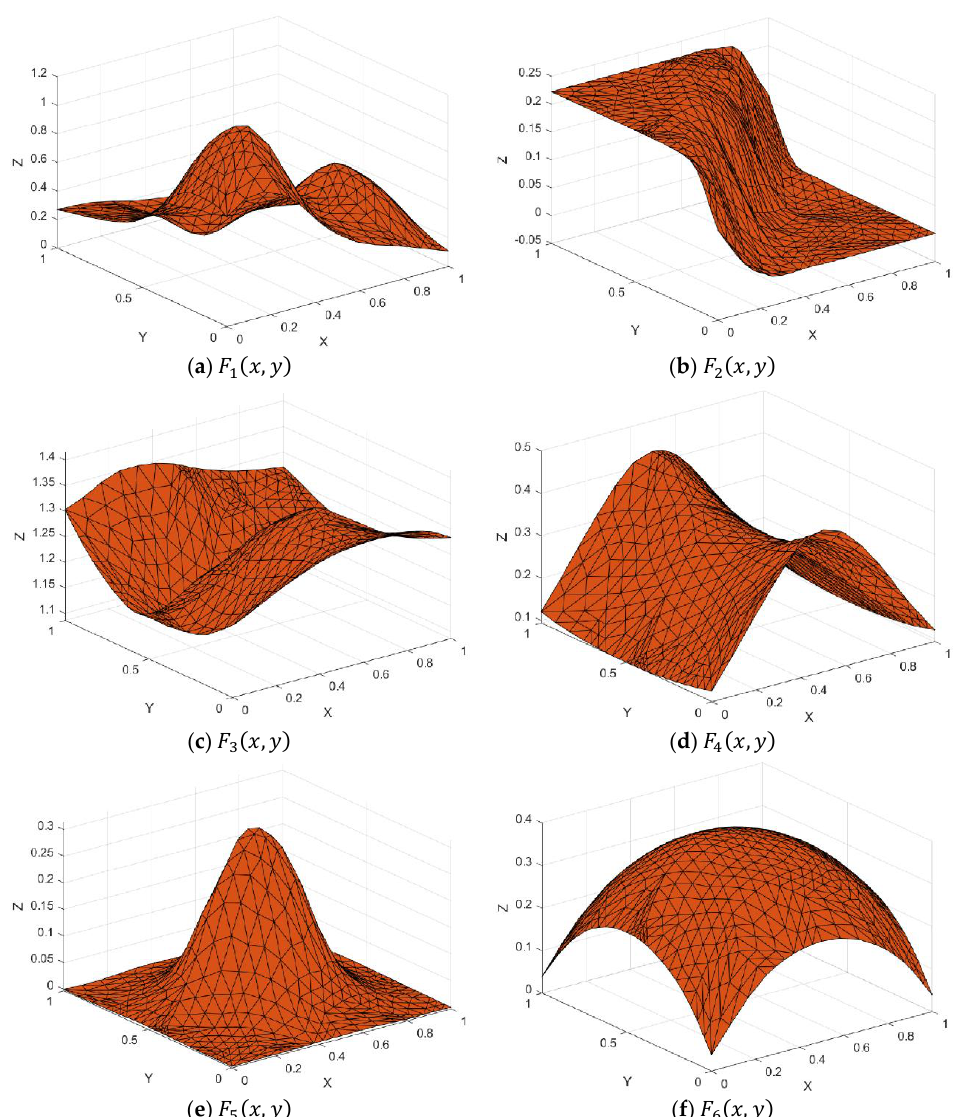
Figure 18. Surface interpolation using Foley and Opitz method and Choice 1 for 65 datasets.